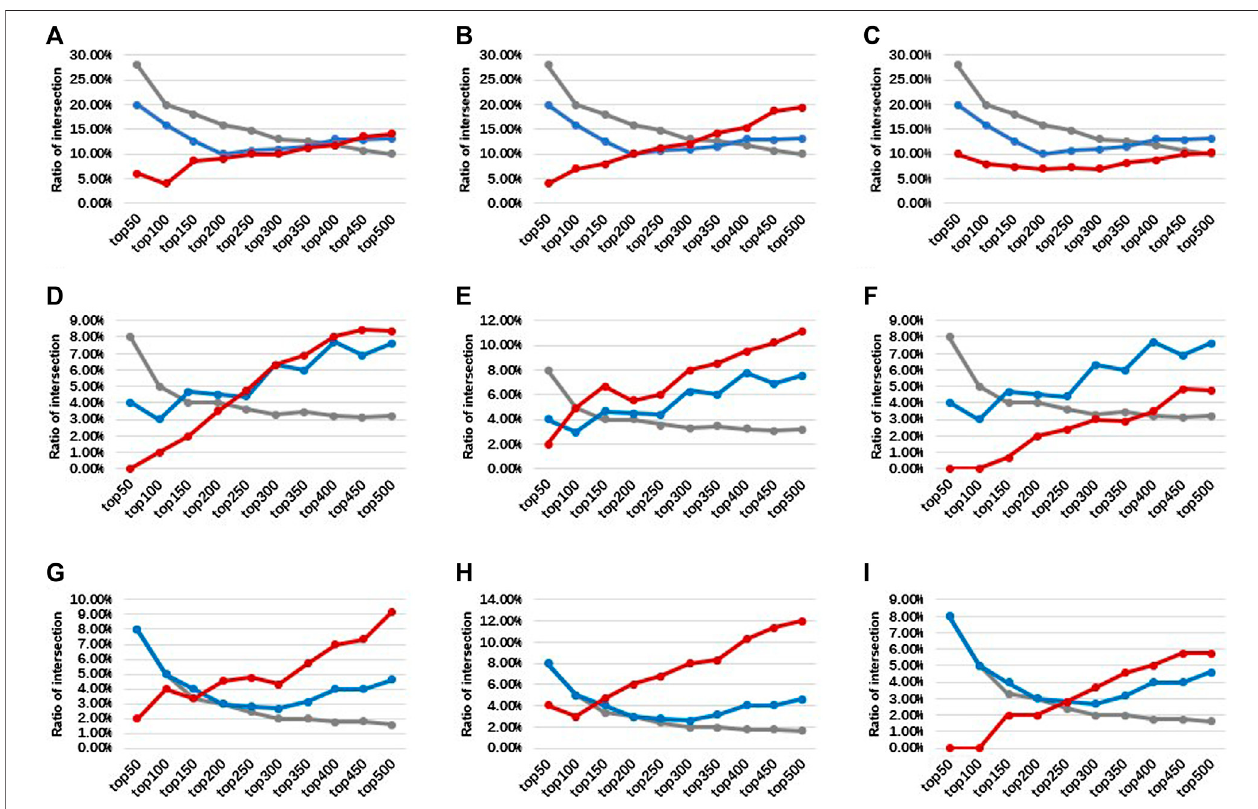
FIGURE 5 | The intersection ratios of top N differential genes/probes between three smoking-related datasets. The gray, blue, and red lines represent the DMPs, DMGs,andSIMPOalgorithmmethods,respectively. (A) ForSIMPO-TSS200algorithm-identi fi eddifferentialgenesbetweenGSE50660andGSE85210dataset. (B) For SIMPO-TSS1500 algorithm-identi fi ed differential genes between GSE50660 and GSE85210 dataset. (C) For SIMPO-TSS200&1,500 algorithm-identi fi ed differential genes between GSE50660 and GSE85210 dataset. (D) For SIMPO-TSS200 algorithm-identi fi ed differential genes between GSE50660 and GSE53045 dataset. (E) For SIMPO-TSS1500 algorithm-identi fi ed differential genes between GSE50660 and GSE53045 dataset. (F) For SIMPO-TSS200&1,500 algorithm-identi fi ed differential genes between GSE50660 and GSE53045 dataset. (G) For SIMPO-TSS200 algorithm-identi fi ed differential genes between GSE53045 and GSE85210 dataset. (H) ForSIMPO-TSS1500algorithm-identi fi eddifferentialgenesbetweenGSE53045andGSE85210dataset. (I) ForSIMPO-TSS200&1,500algorithm-identi fi ed differential genes between GSE53045 and GSE85210 dataset.